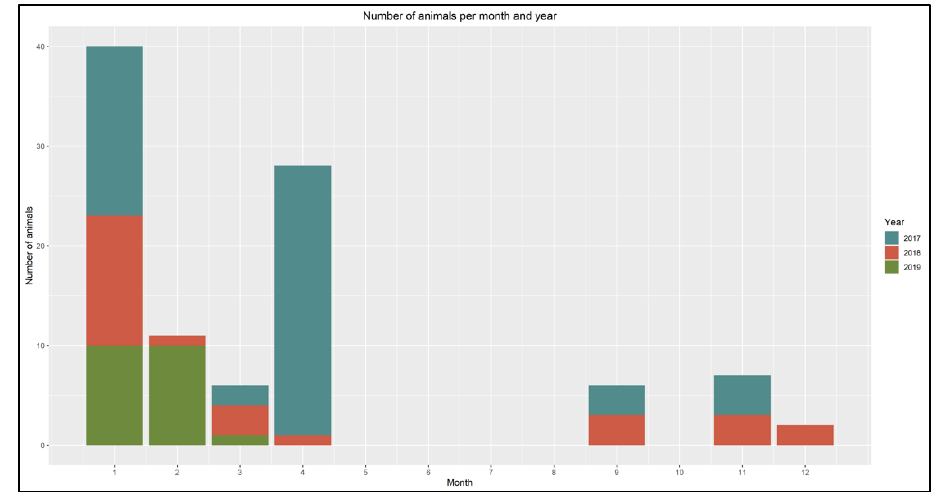
Figure 2. Distribution of bycaught Common Eiders by month and year from January 2017 to March 2019.